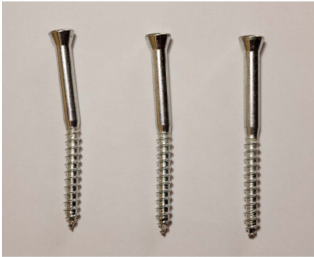
Figure 8. Yielding of the 10 mm ˆ 120 mm screws connecting skin to frame (single plastic